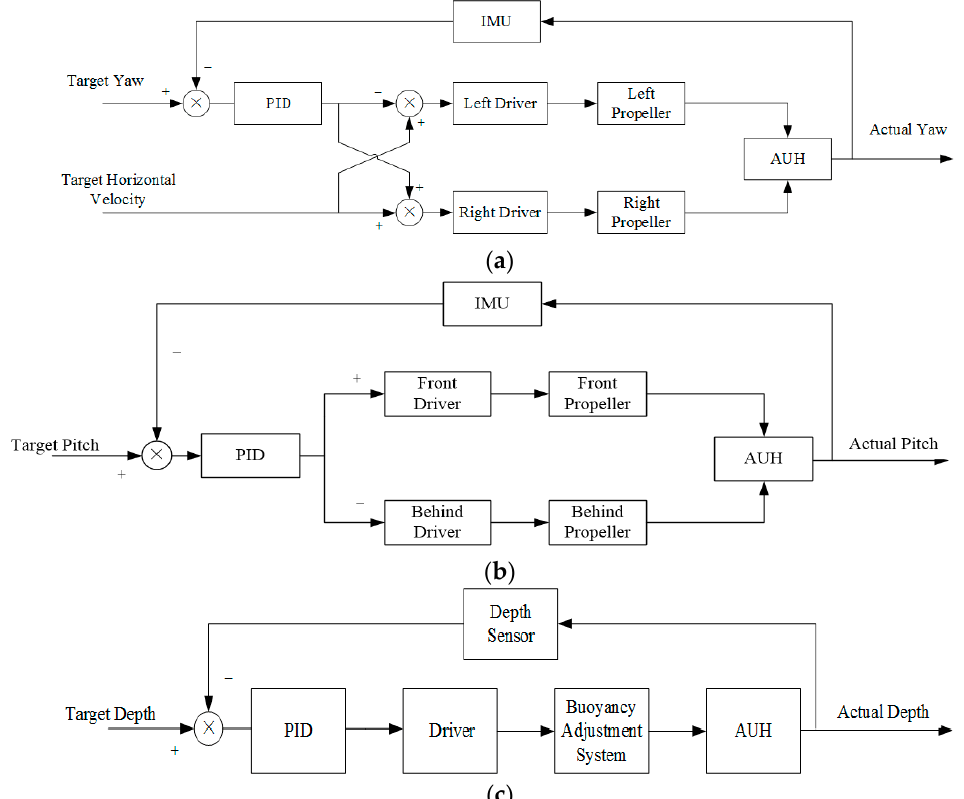
Figure 9. Control block diagram of ( a ) horizontal propellers; ( b ) vertical propellers; ( c ) buoyancy adjustment system.